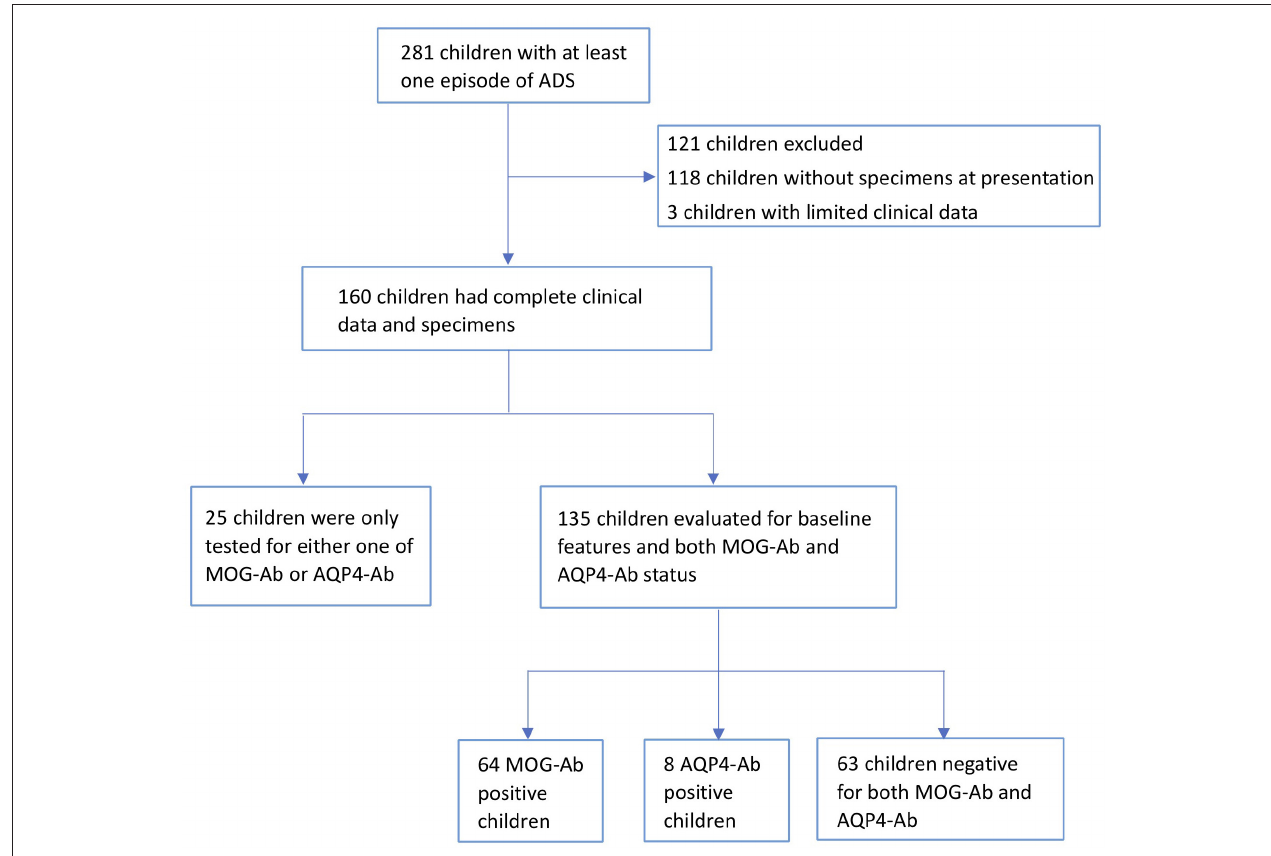
FIGURE 1 | Flow diagram. A total of 160 participants with acquired demyelinating syndromes (ADS) with complete clinical data and serum or cerebrospinal fluid (CSF) specimens were tested for MOG-antibody (MOG-ab) and AQP4-antibody (AQP4-ab). For 135 participants with both antibodies tested, 64 participants were MOG-ab-positive, 8 participants were AQP4-ab-positive, and 63 participants were negative for both